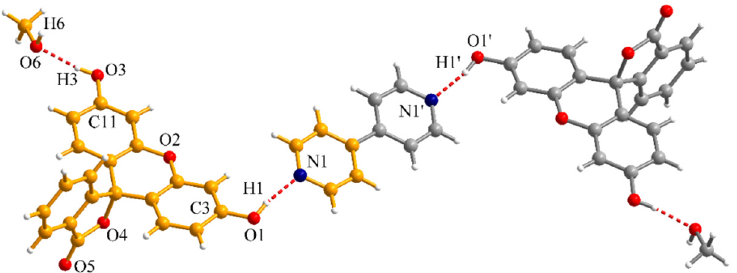
Figure 4. Crystal structure of 2 . The asymmetric unit is depicted in orange. Symmetry code: ’ = 3 − x, 3 − y, 2 − z.